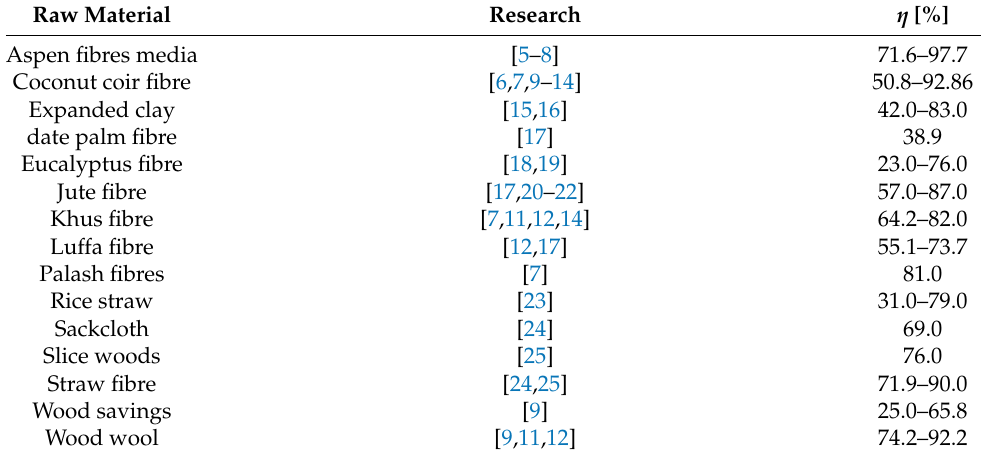
Table 1. Cooling efficiency ( η ) of cooling pad research studies based on organic raw materials.